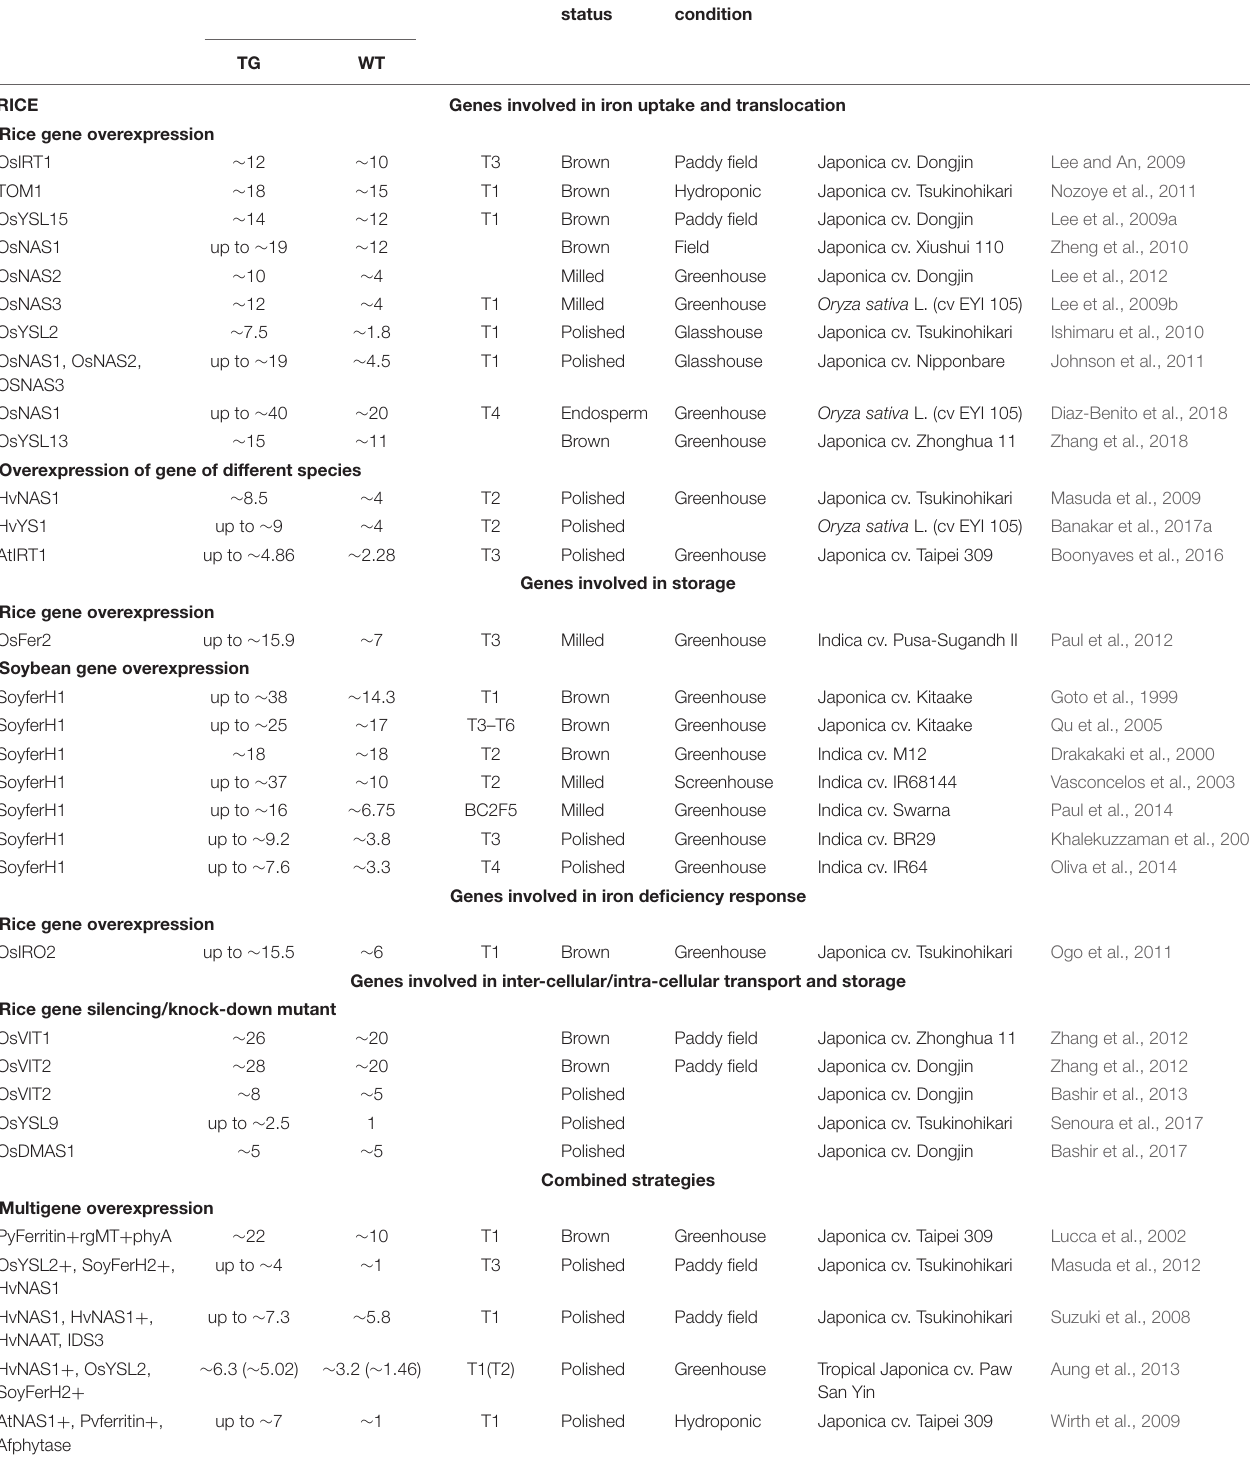
TABLE 1 | Review on transgenic approaches to develop iron-rich rice and wheat